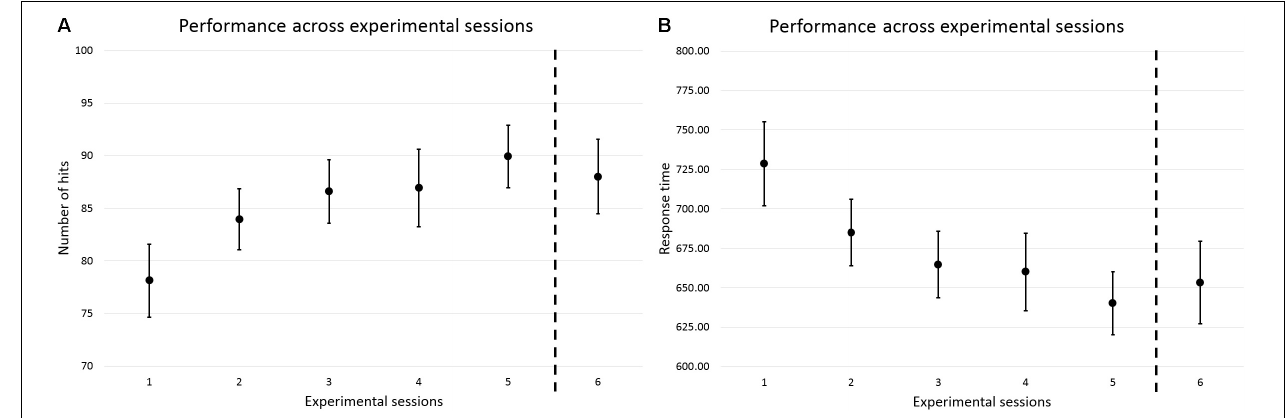
FIGURE 3 | Performance across experimental sessions, in terms of number of hits (A) and RT (B) . The round dots represent the averages of the three practice trials from the first block of each experimental session, which were used to measure motor learning. The vertical dashed lines represent the 1-week long-term retention interval spanning between Sessions 5 and 6. Group data are displayed. Error bars = 95%